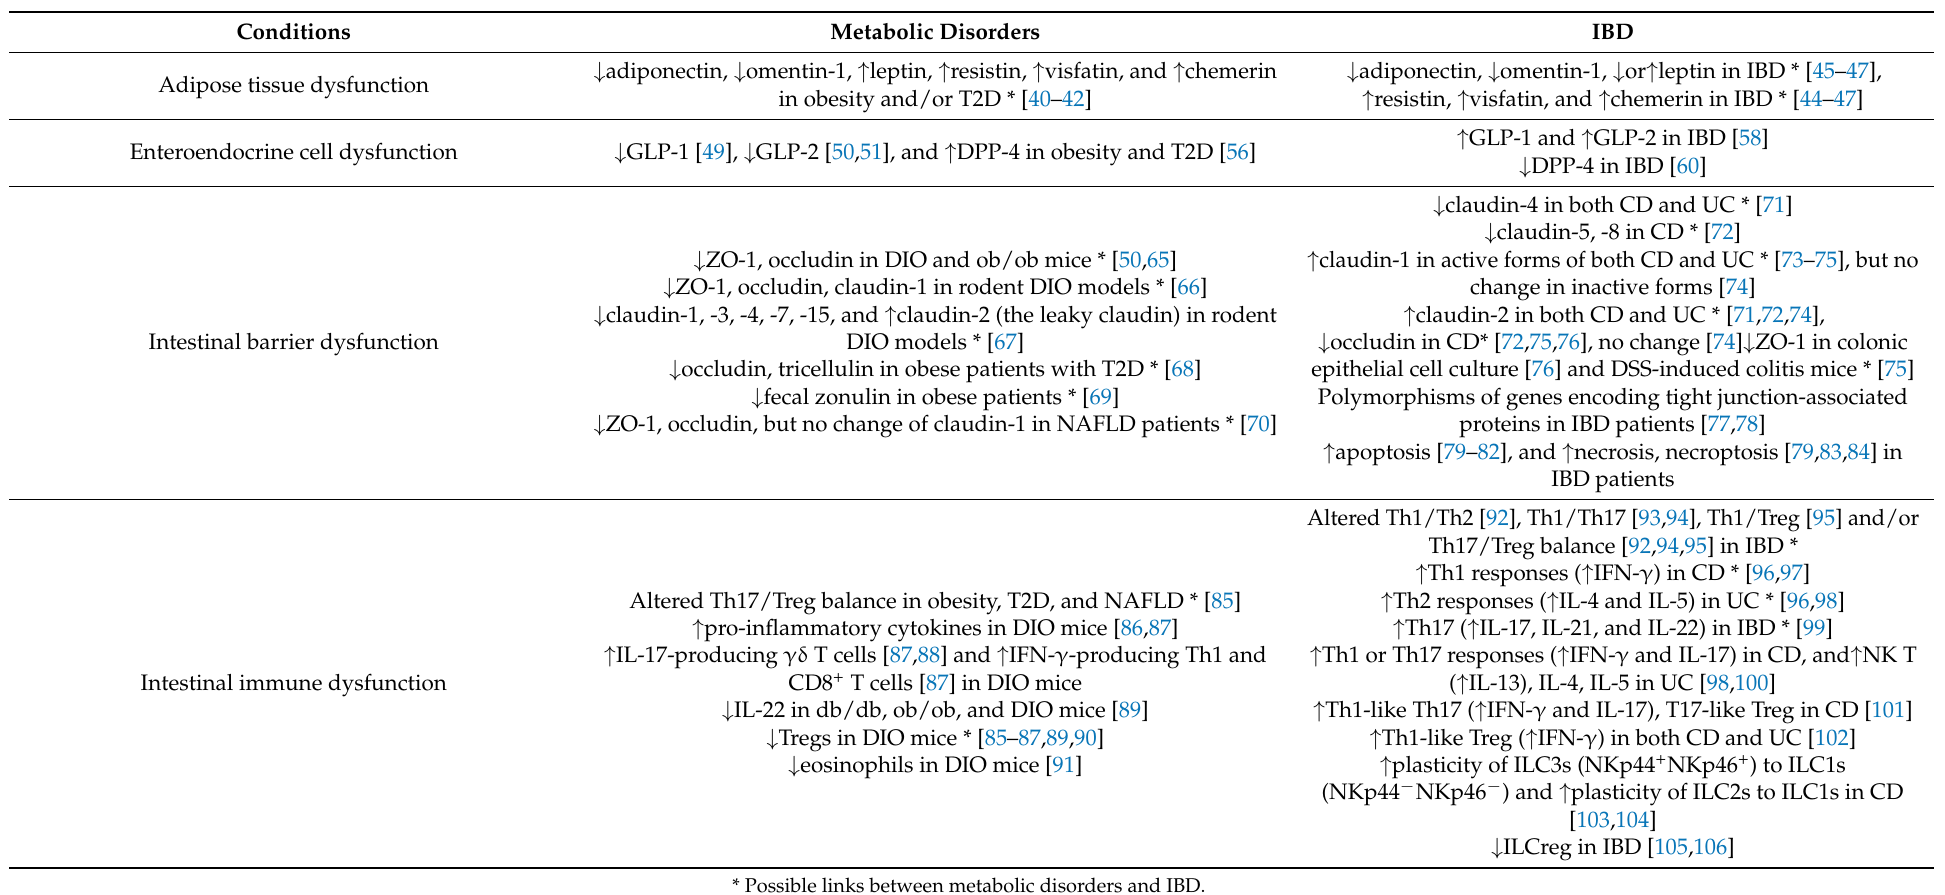
Table 1. Molecular mechanisms underlying the impairment of adipose tissue function, enteroendocrine function, intestinal barrier integrity, and intestinal immune function in metabolic disorders and